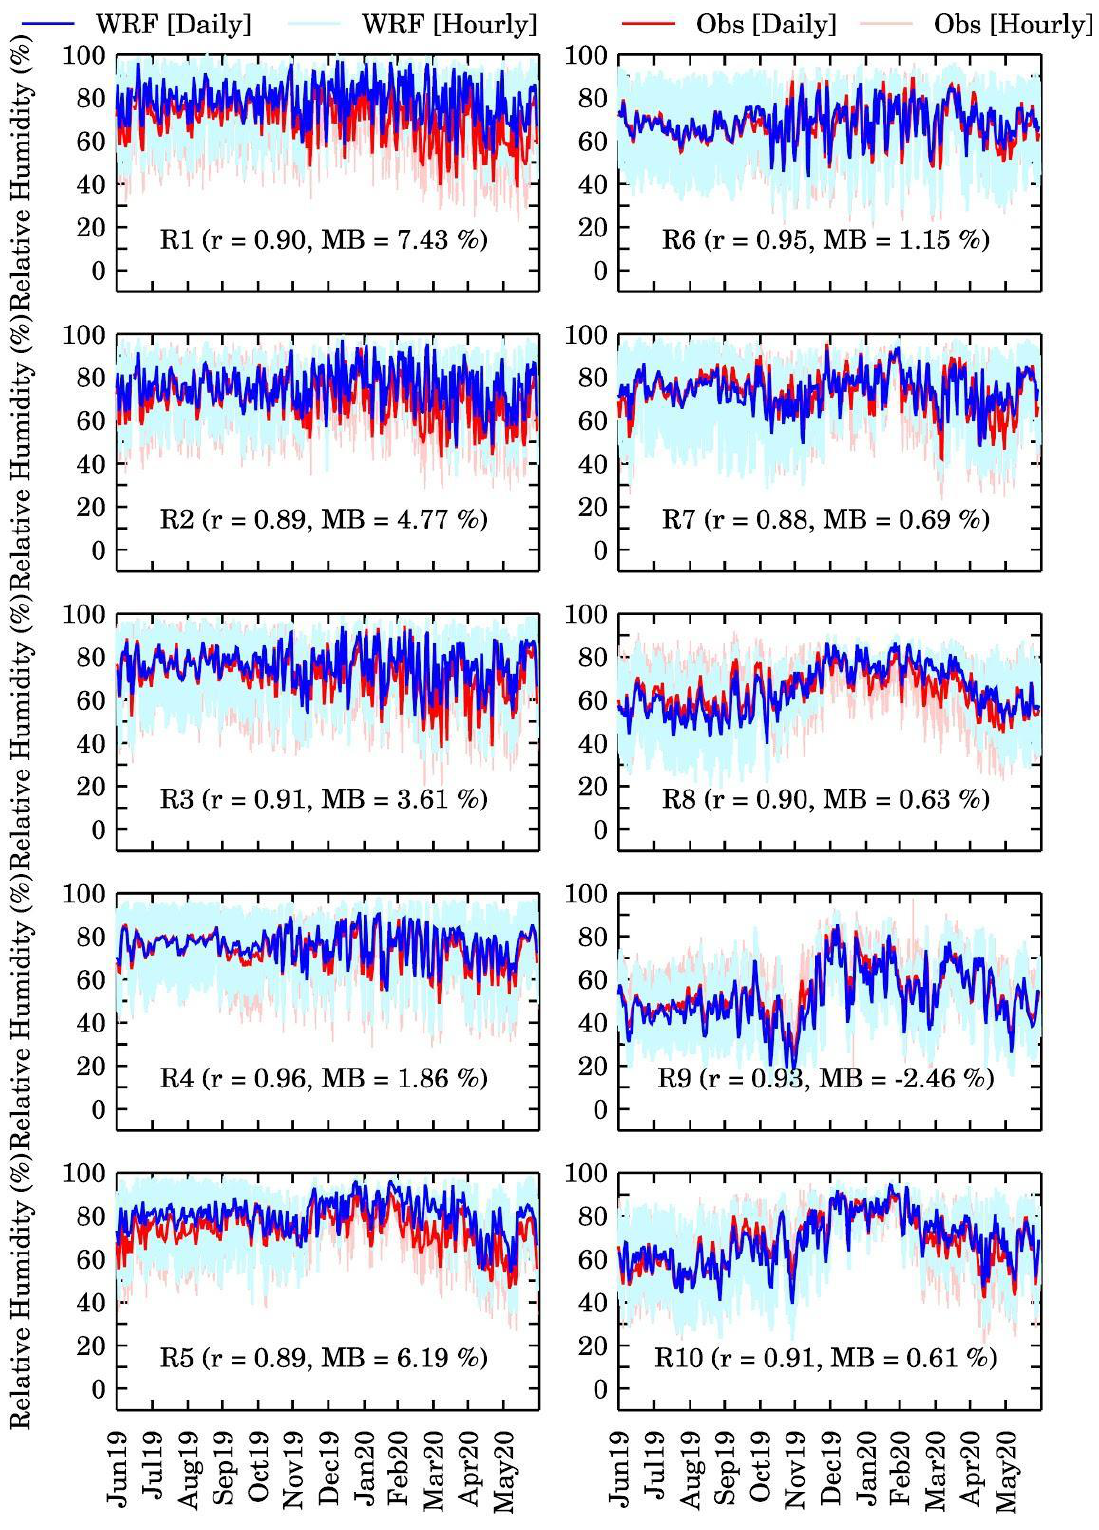
Figure 6. Seasonal variations in hourly and daily observed and model-simulated 2 m relative humidity in 10 EPA regions during June 2019 to May 2020. r and MB for each region estimated using paired data for the full year are also shown.